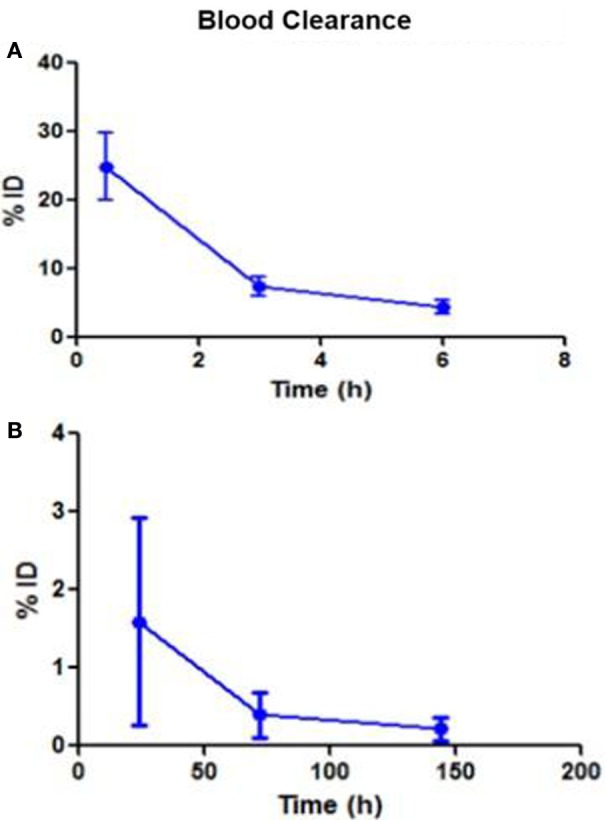
Blood clearance pattern of 177Lu-EDTMP. (A) Percent fraction of the injected dose (%ID) remaining in blood over the first 6 h (B) over the next 144 h.